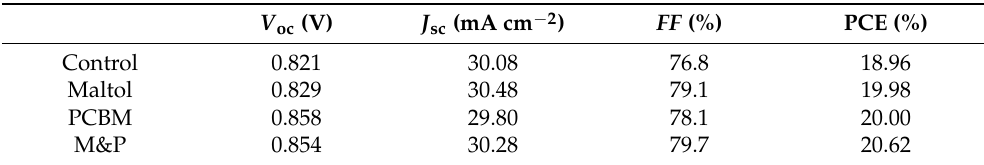
Table 1. A comparison of the photovoltaic performance parameters based on the four treatments (Control, PCBM, Maltol, and M&P) under reverse